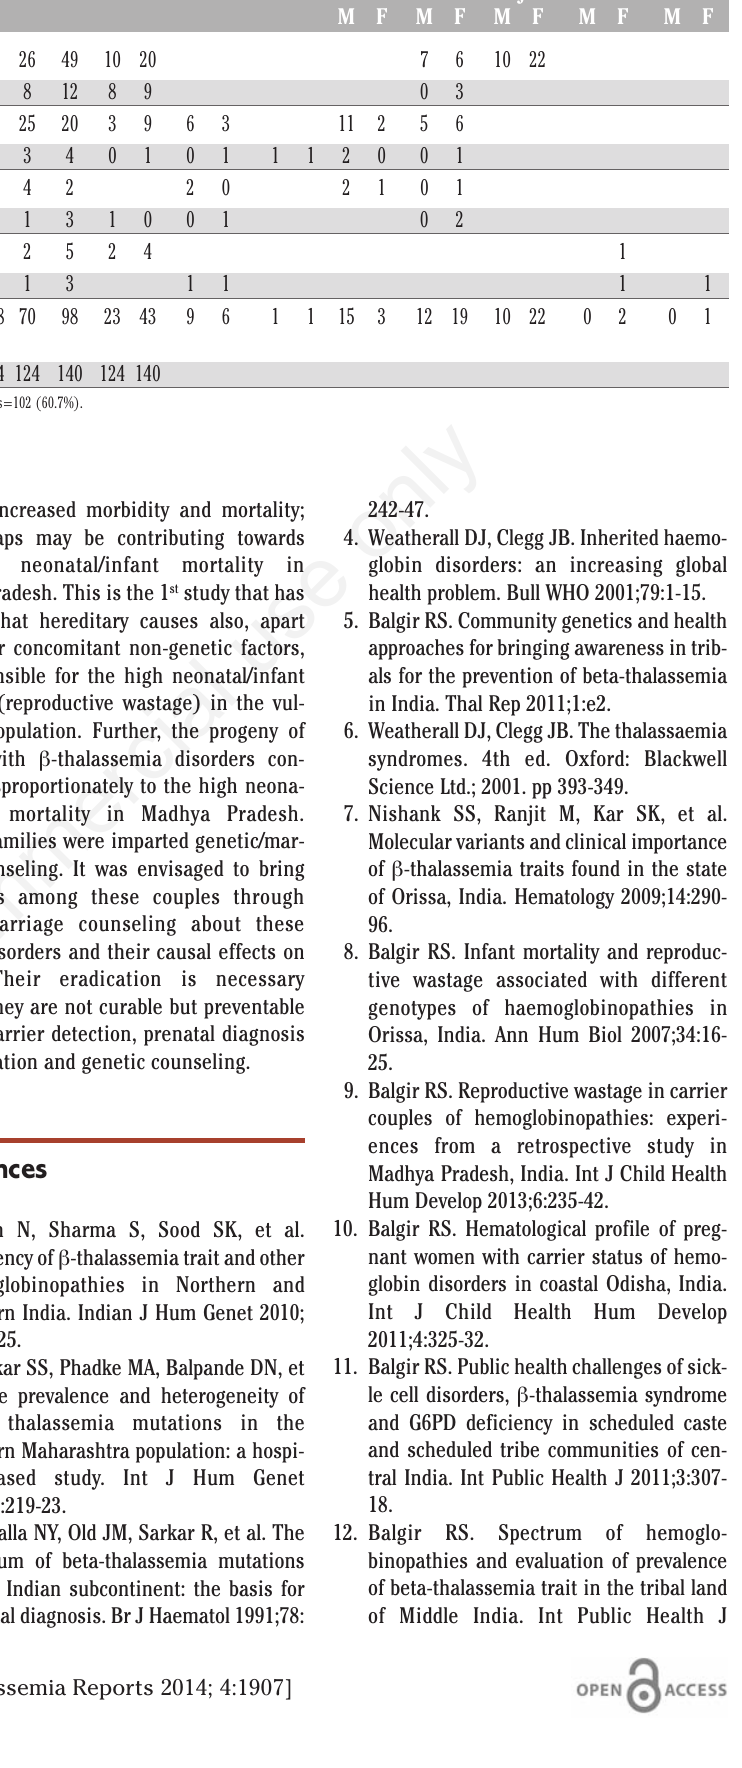
Table 4. Comparison of surviving children (figures in absolute numbers) of carrier couples with and without different b -thalassemia disorders.